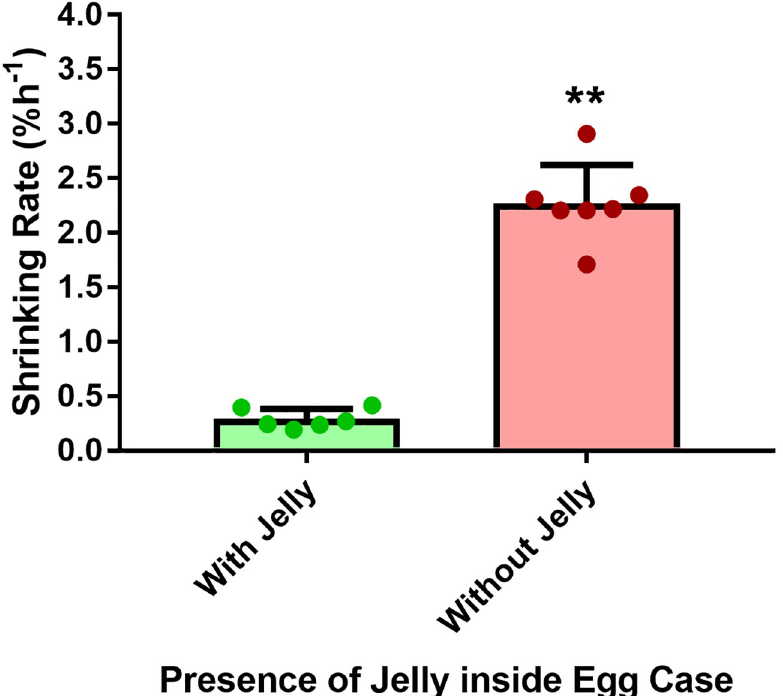
Fig 15. Shrinking rate of S . stellaris egg cases (% in area h -1 ) with and without jelly. Values represent mean ± SD, while points show individual measurements. Asterisk indicates statistically significant effect of jelly on the rate of egg case shrinking (Mann-Whitney U test, P <